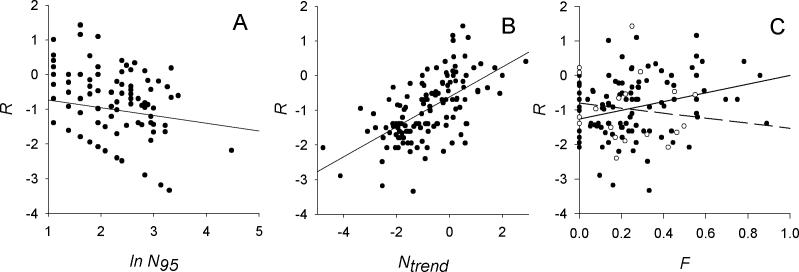
Population Growth Explained by Ecological Factors and
Pgi Genotype
Population growth rate (
R) is plotted against the logarithm of population size (
N
t; A), regional change in population sizes (
N
trend; B), and
Pgi genotype frequency
F (C). In panel (C), populations in small (
A < 0.8 ha) and large habitat patches have been identified with closed (continuous line) and open symbols (broken line), respectively. For statistics, see
Table 1.